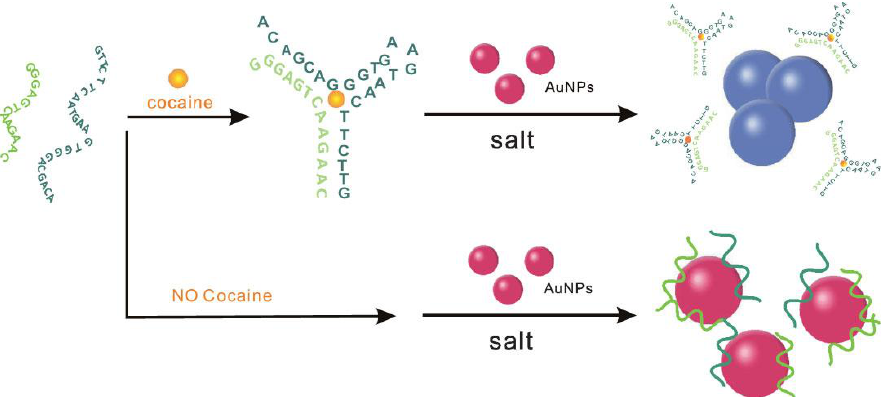
Figure 3. Scheme for the engineered cocaine aptamer and the visual detection of cocaine based on the red-to-blue color change of Au NPs. Reprinted with permission from Reference